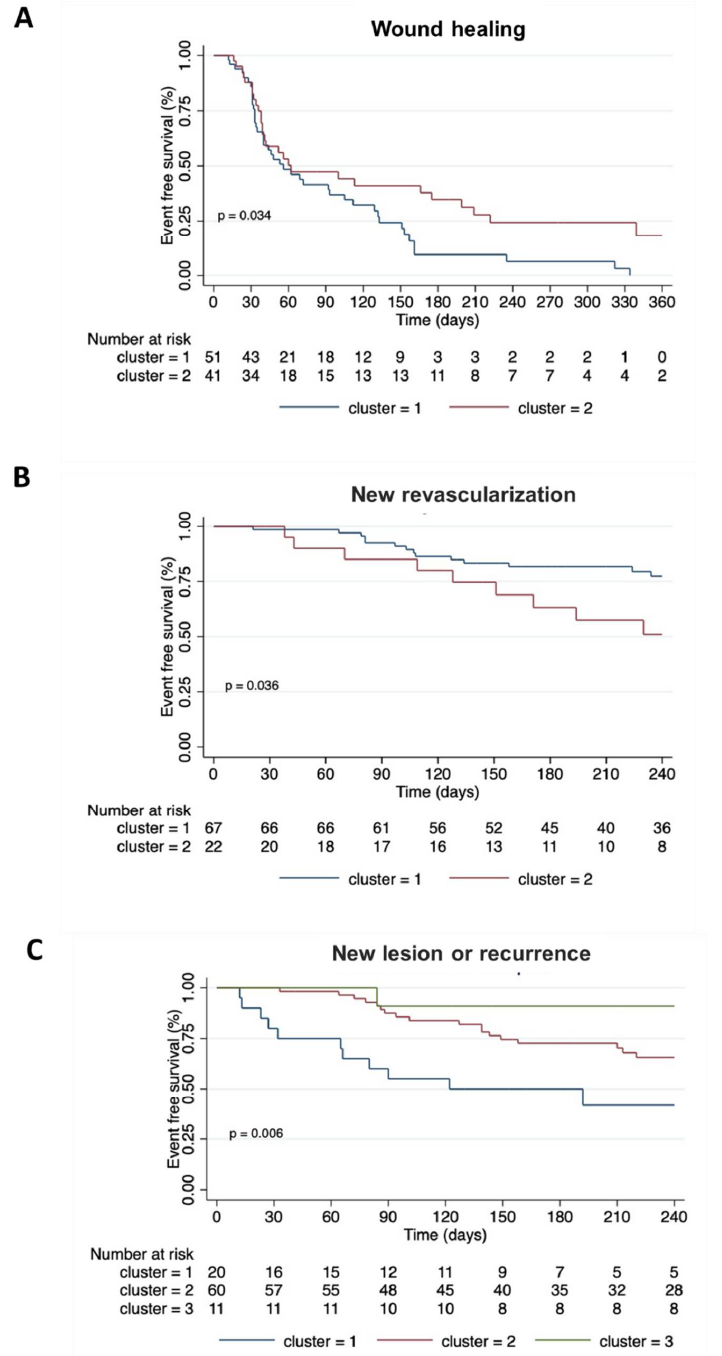
Figure 1. Event-free survival curves obtained by the Kaplan–Meier estimate showing significant differences between clusters toward: ( A ) DFU healing within three months from treatment; ( B ) new lower limb revascularization; ( C ) new lesions or recurrences. The log rank test was performed to compare survival functions. For each cluster, the number of event-free patients at any given time during follow-up is shown below the